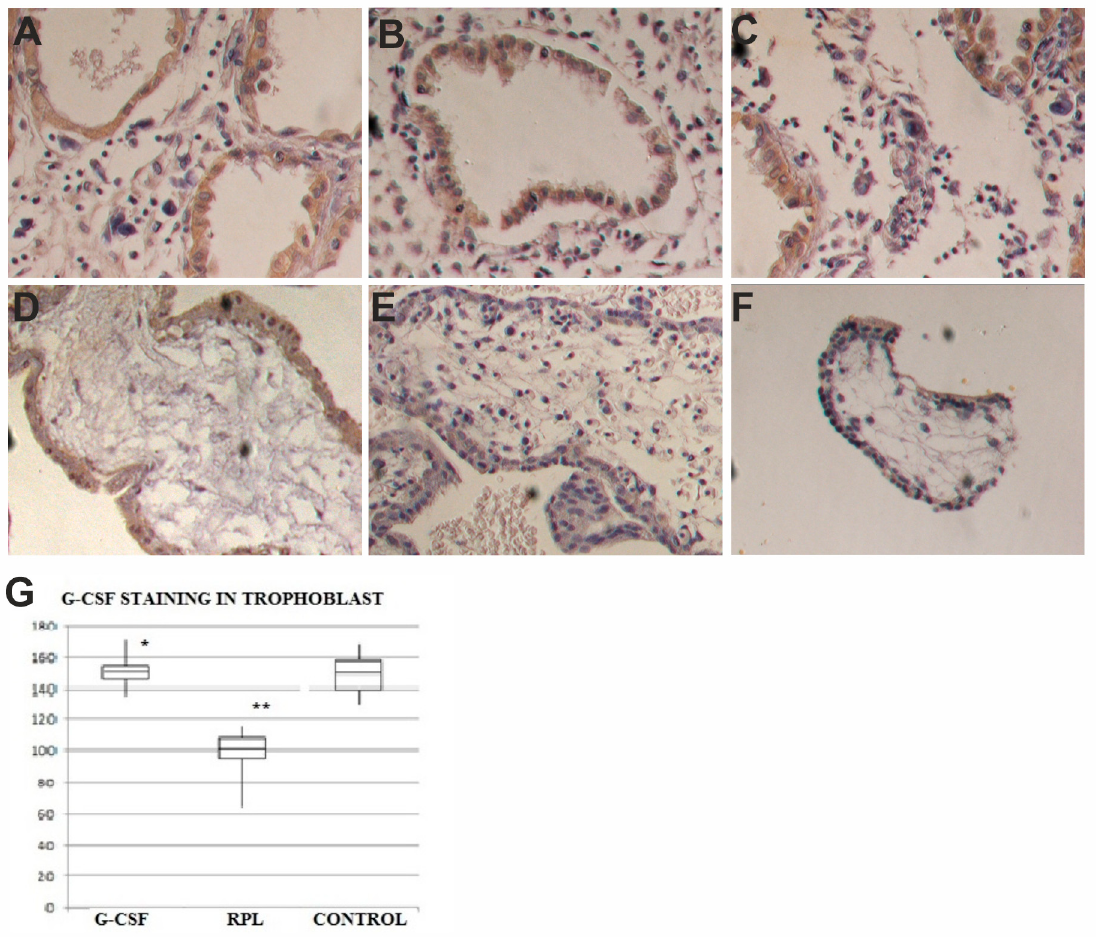
Figure 3. G-CSFR expression in decidua and trophoblast of first trimester pregnancy. In decidua of G-CSF treated group ( A ), in the no treated RPL group ( B ) and Control pregnancies ( C ) there was the same staining levels in the epithelial cells but no in the stroma for G-CSFR (brown color) (400 × ). In trophoblast of G-CSF treated samples ( D ), the syncytiotrophoblast was moderately positive to G-CSFR (brown colour) (400 × ). In trophoblast of RPL no-treated samples ( E ), the syncytiotrophoblast was strongly positive to G-CSFR, more than in other two groups (400 × ). In trophoblast of Control samples ( F ), the syncytiotrophoblast was moderately positive to G-CSFR (brown color) similar to G-CSF treated samples (400 × ). The graph ( G ) showed immunohistochemical staining semi quantitative HSCORE for G-CSFR (charts display median and quartiles with whiskers showing the range): There was a statistically significant di ff erences between G-CSF vs. RPL (* p < 0.001) and RPL vs. Control (** p < 0.001).